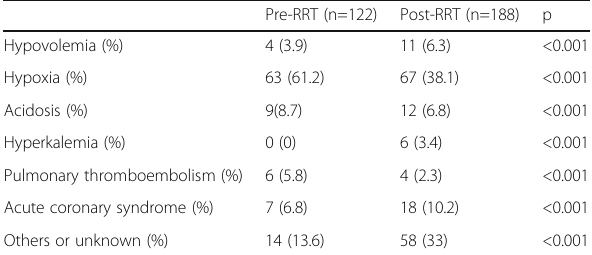
Table 2 (abstract 0315). Main reason for cardiac arrest before and after rapid response team